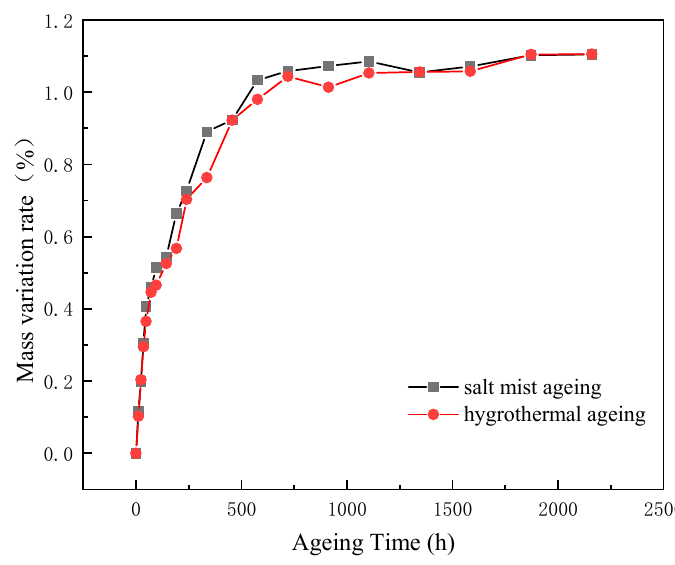
Figure 3. Rate of change in the mass of the epoxy resin during ageing. The fractional moisture absorption of a plane sheet material can be expressed by the following formula: